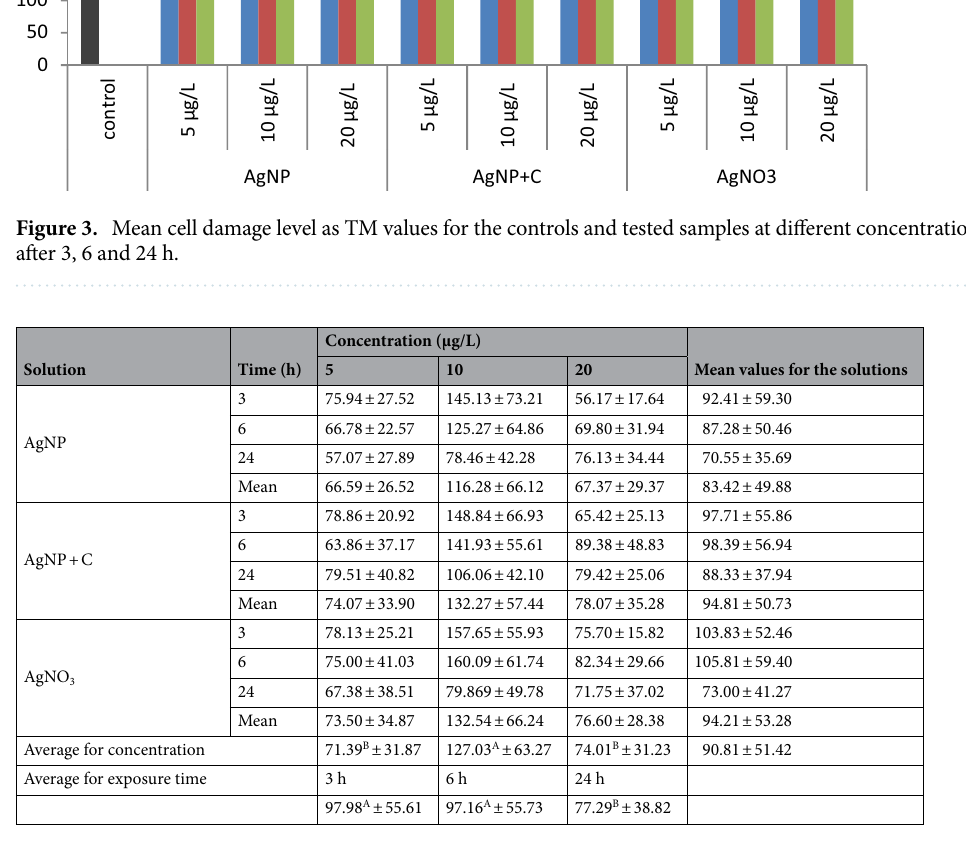
Table 2. The genotoxicity of silver solutions based on the values of the Tail Moment, TM. A,B—mean values for concentration and exposure time marked with different letters vary significantly ( p ≤ 0.05).